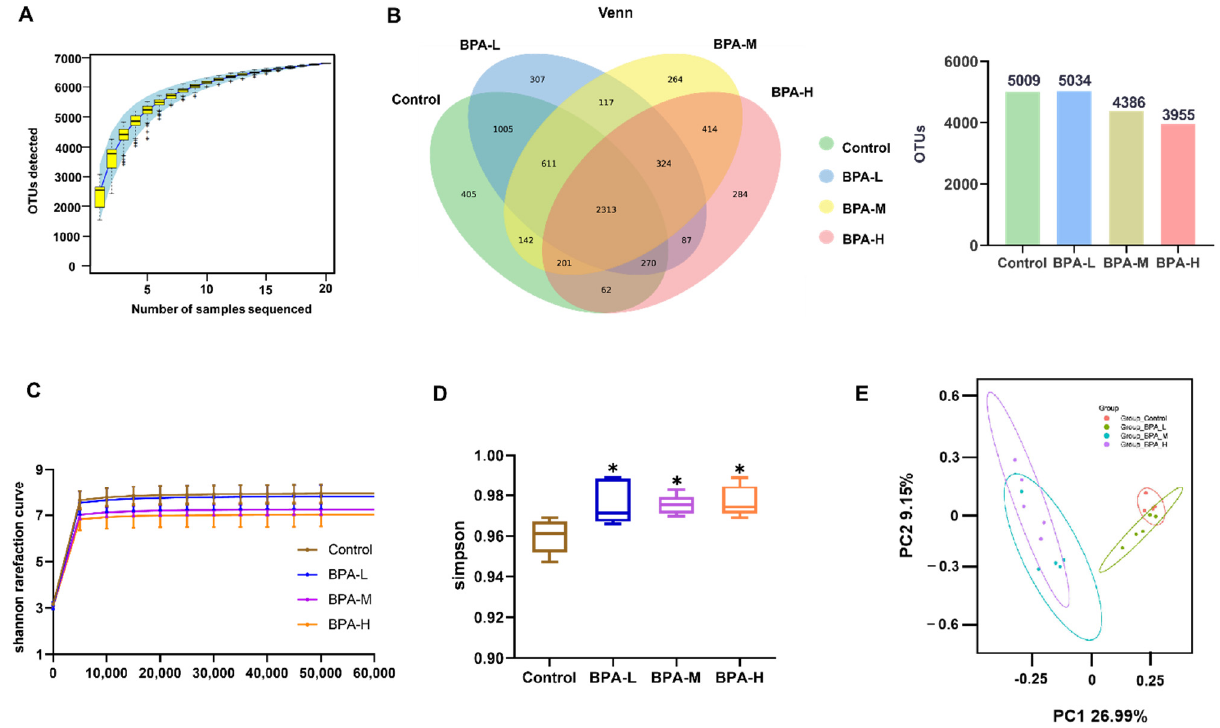
Figure 5. Effects of BPA on the structure of gut microbiota. ( A ) OTU numbers. ( B ) Venn diagram illustrated the unique and shared OTUs among groups. ( C ) Shannon rarefaction curve, ( D ) Simpson index, and ( E ) PCA of gut microbiota communities. * p < 0.05 vs. Control group .